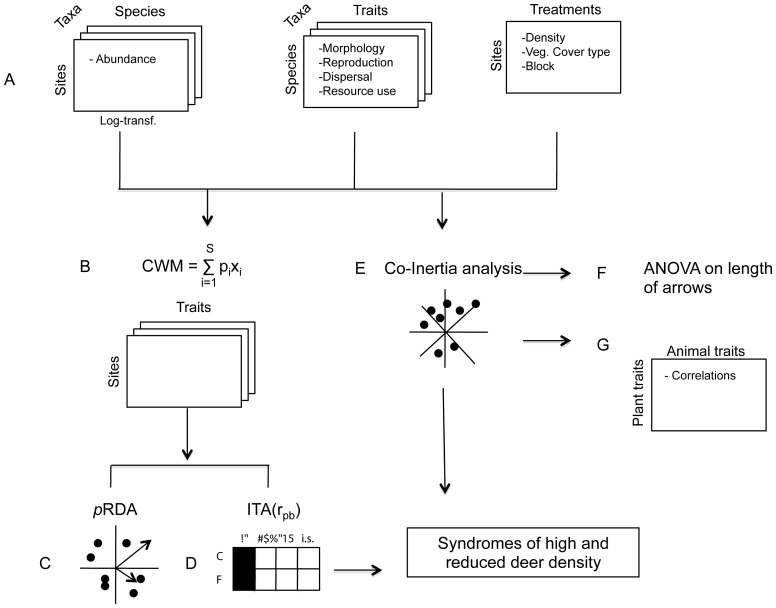
Diagram of the statistical approach.Sequence of the statistical analyses used to assess the functional syndromes of plant and animal traits associated with deer density. Distinct matrices were used for plants, ground beetles and songbirds (A). The matrix Treatment was the same for each group with the variables vegetation cover type (uncut forests and cut-over areas), deer density and block (A). The matrices CWM (community weighted mean) of traits by sites combine the Abundance (pi) and Trait (xi) matrices using weighted averaging (B). The partial redundancy analysis (pRDA; C), indicator traits analysis (ITA; D) and co-inertia analysis (E) were conducted with the CWM matrices. The impact of deer density on the degree of association of functional traits between two taxonomic groups (length of arrows in co-inertia graph) was tested with ANOVA (F). Finally, a correlation matrix between plant and animal traits was calculated (G)